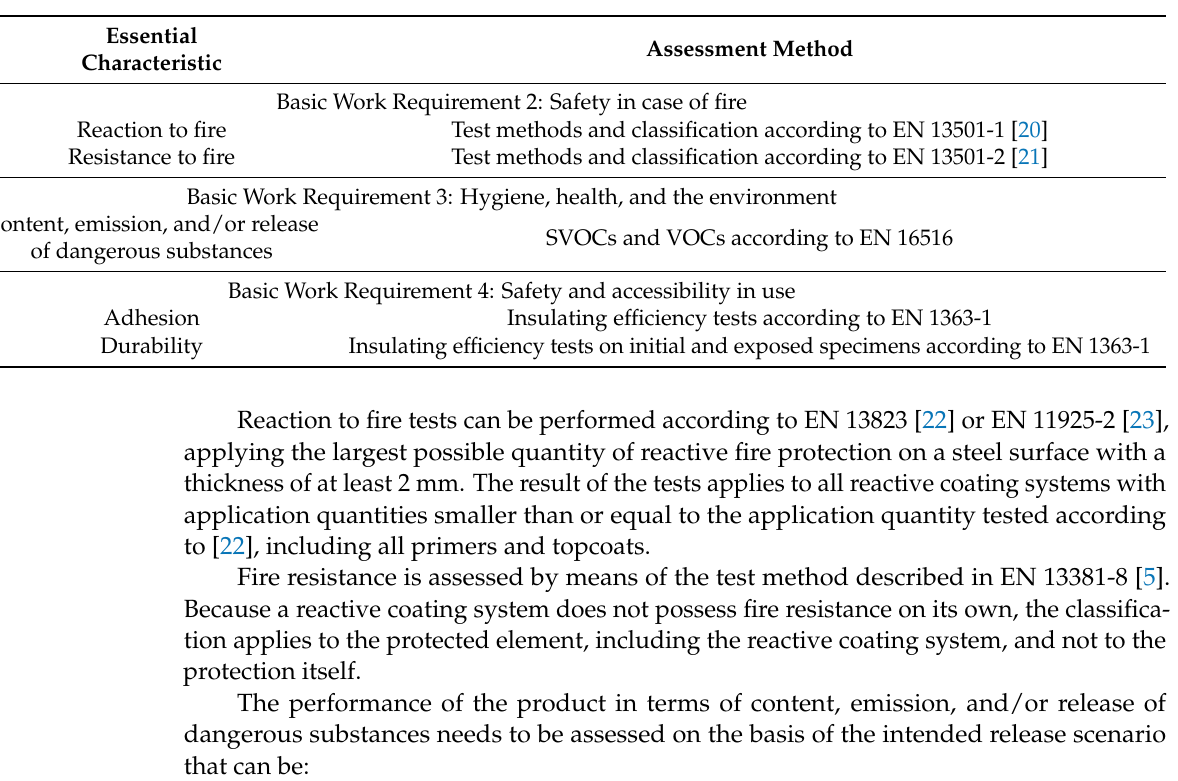
Table 2. Essential characteristics and relative assessment methods for reactive coating systems according to EAD